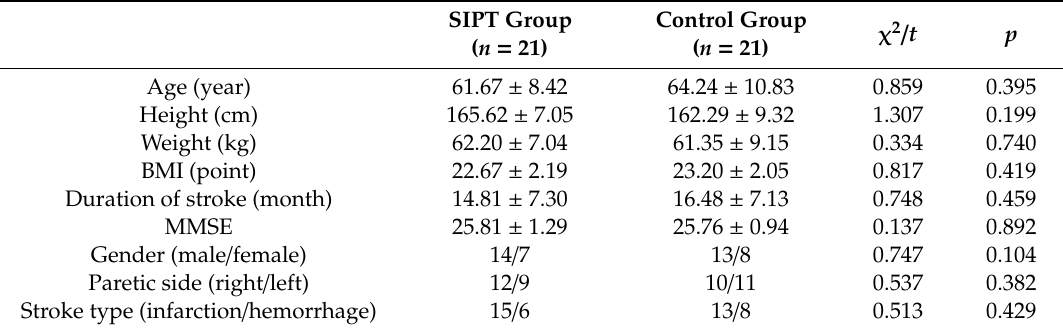
Table 1. General characteristics of the